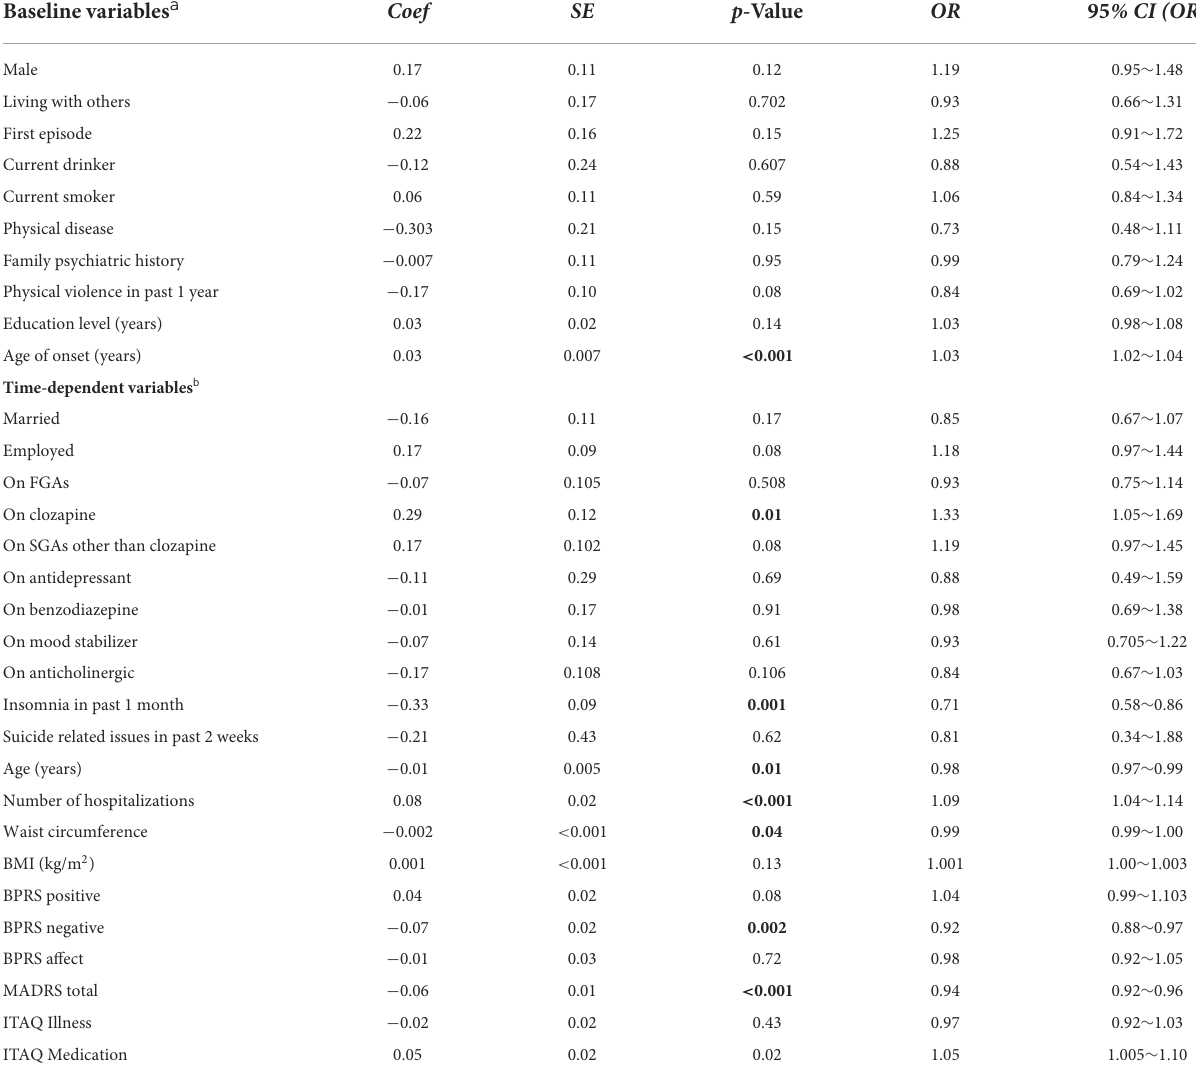
TABLE 5 Generalized Estimating Equations (GEE) results modeling risk factors associated with WHOQOL psychological domain in 491 patients with schizophrenia. Baseline variables